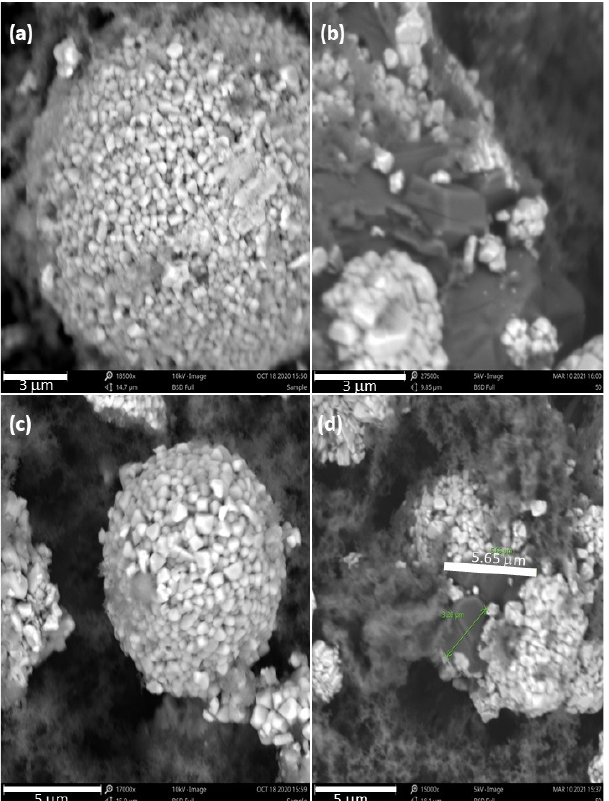
Figure 6. SEM images of pristine NMC811 and rGO/NMC811 cathode material before cycling the batteries. ( a ) A close-up view of pristine NMC811 before battery cycling. Image shows the neatly arranged granules that form a tightly packed NMC811 particle. ( b ) A close-up view of rGO/NMC811 mixture before battery cycling. ( c ) An expanded view of pristine NMC811 before battery cycling. ( d ) An expanded view of rGO/NMC811 before cycling the battery. The amount of rGO additive used was 5wt% of the composite rGO/NMC811 cathode